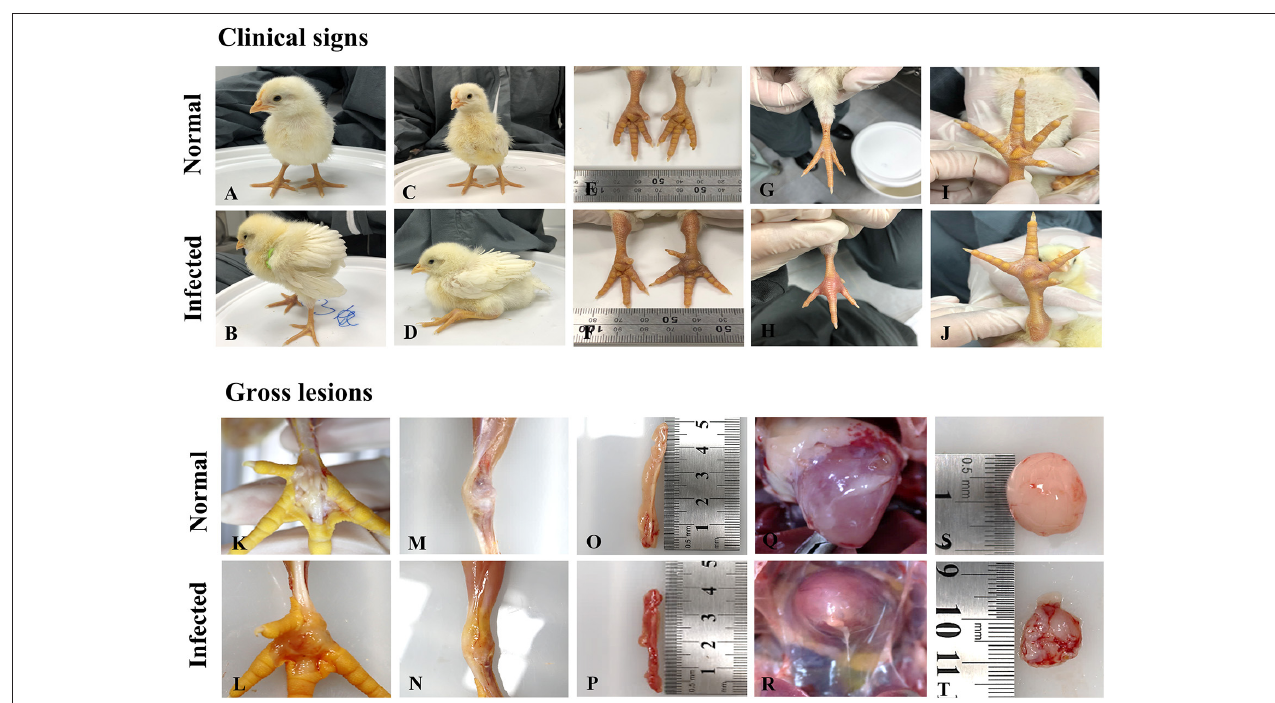
FIGURE 1 | Clinical signs and pathological changes in SPF chicken after ARV isolates originating from wild birds (A) The control group was normal; (B) Chickens displaying depression, drowsiness, and fluffy feathers at 3 dpi; (C) The control group was normal; (D) Chickens displaying lameness at 3 dpi; (E) The leg of chickens in the control group was normal; (F) Tenosynovitis associated with the entire right leg 4 dpi; (G) The foot of chickens in the control group was normal; (H) Severe redness in the foot at 4 dpi; (I) The footpad of chickens in control group was normal; (J) Severe swelling in the footpad at 4 dpi; (K) The footpad of chickens in the control group was normal; (L) Swelling, edema, and hemorrhages in the footpad at 5 dpi; (M) The articular cavity of chickens in the control group was normal; (N) Swelling and edema in the articular cavity; (O) The pancreas of chickens in the control group was normal; (P) Pancreas with atrophy and hemorrhage at 5 dpi; (Q) The heart of chickens in the control group; (R) Heart with edema and hydropericardium at 15 dpi; (S) The bursa of chickens in the control group was normal; (T) Moderate atrophy and hemorrhages in the Bursa of Fabricius.